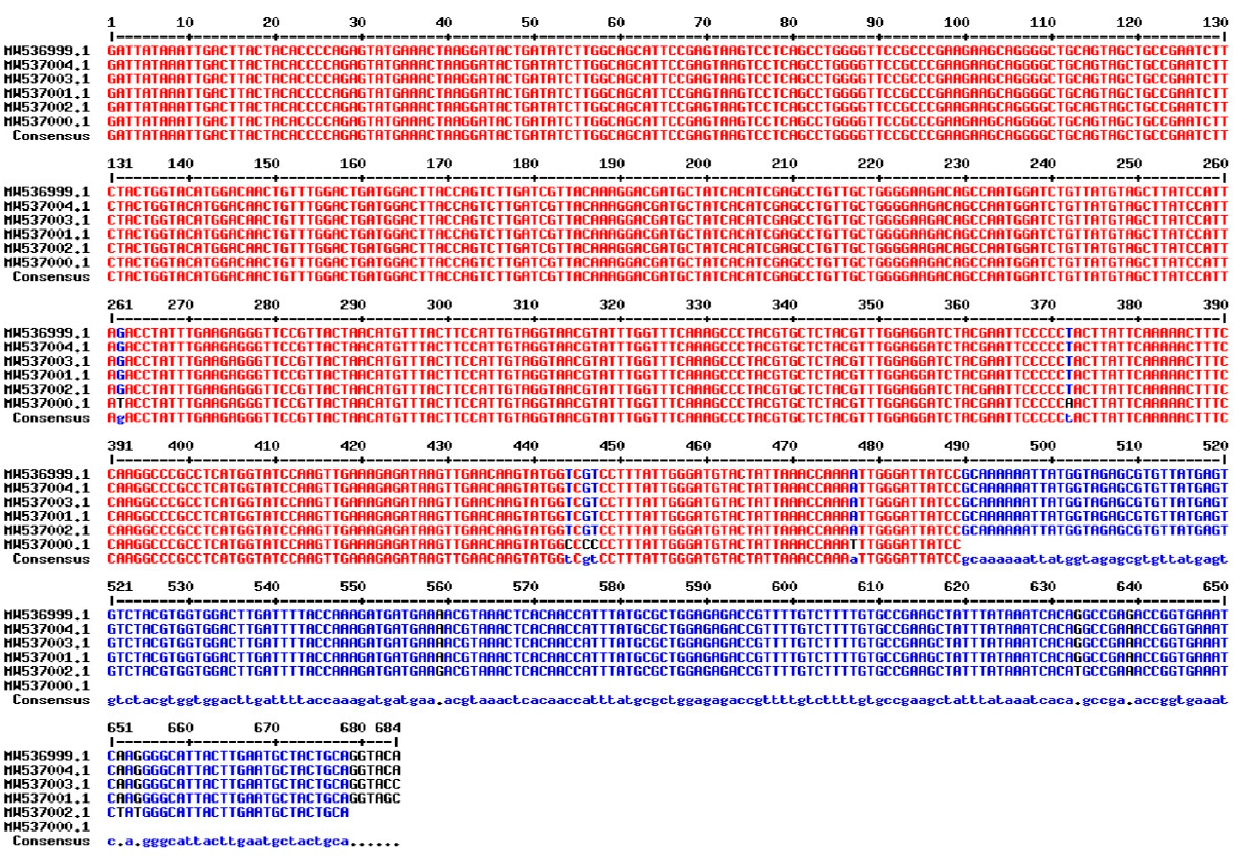
Figure 6. Sequence alignment of rbcL gene of the selected six T. aestivum genotypes using Multalin ver. 5.4.1 (http://multalin.toulouse.inra.fr/multalin/, accessed on 15 August 2022)